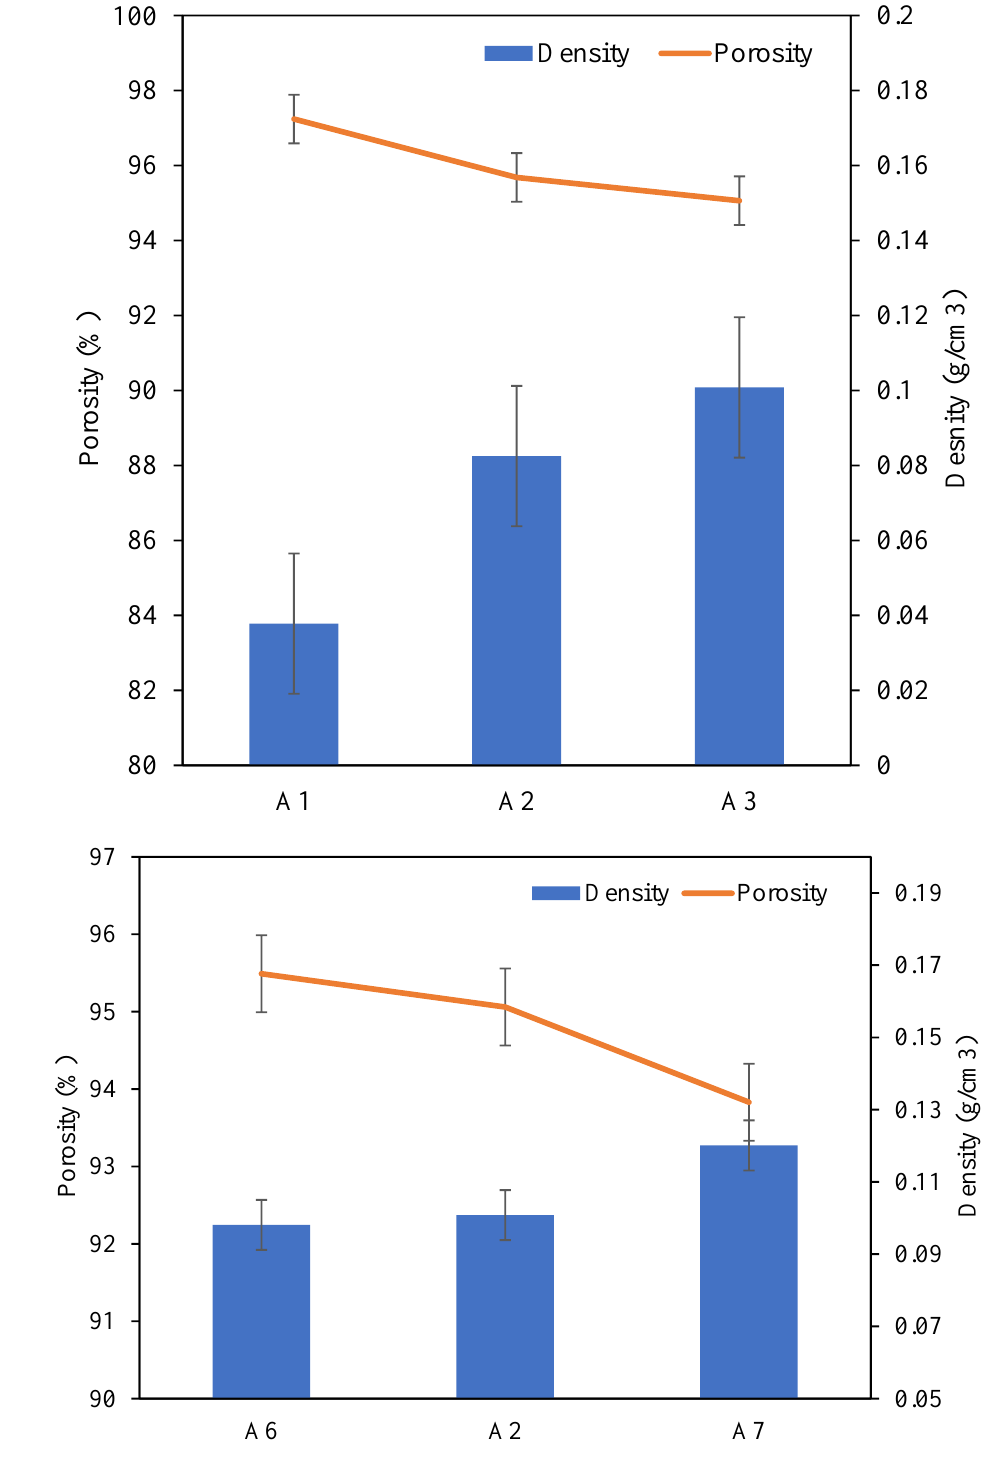
Figure 4. Density and porosity of AAs with varying aluminum content at 1.5 wt.% CMC and 1.5 wt.%